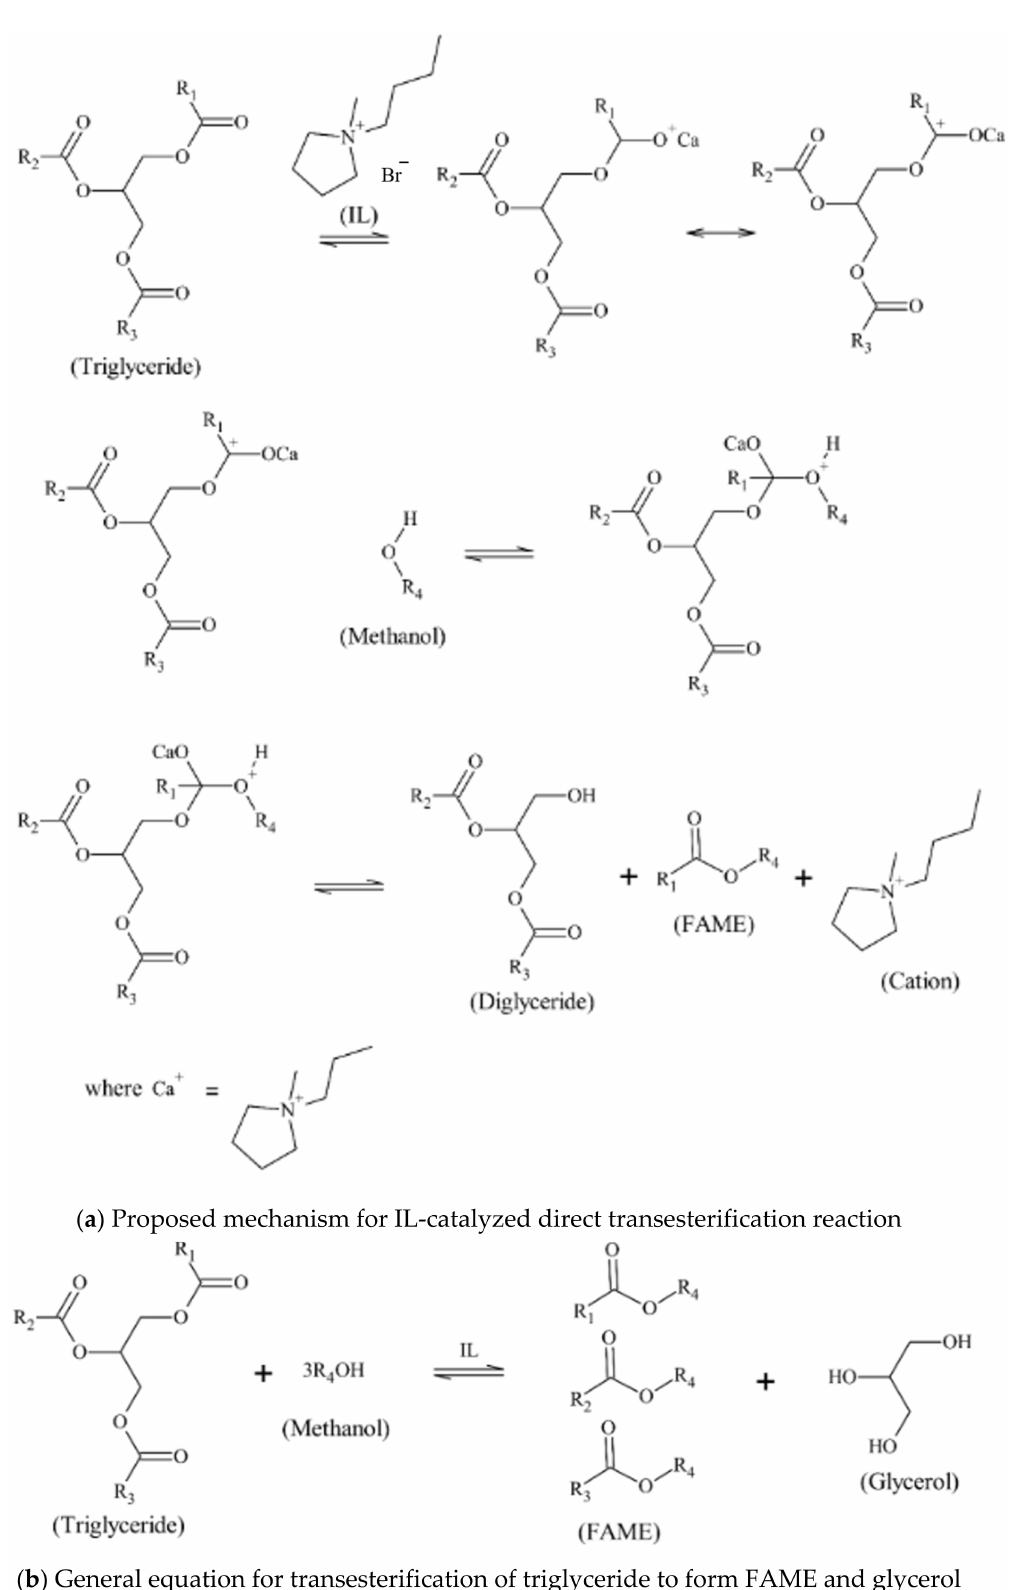
Figure 7. Proposed schematic representation of TG and methanol mechanism by pyrrolidinium-based IL as a catalyst, ( a ) the proposed mechanism for IL-catalyzed DT reaction, ( b ) the general equation for DT of TG to form FAME and glycerol as the